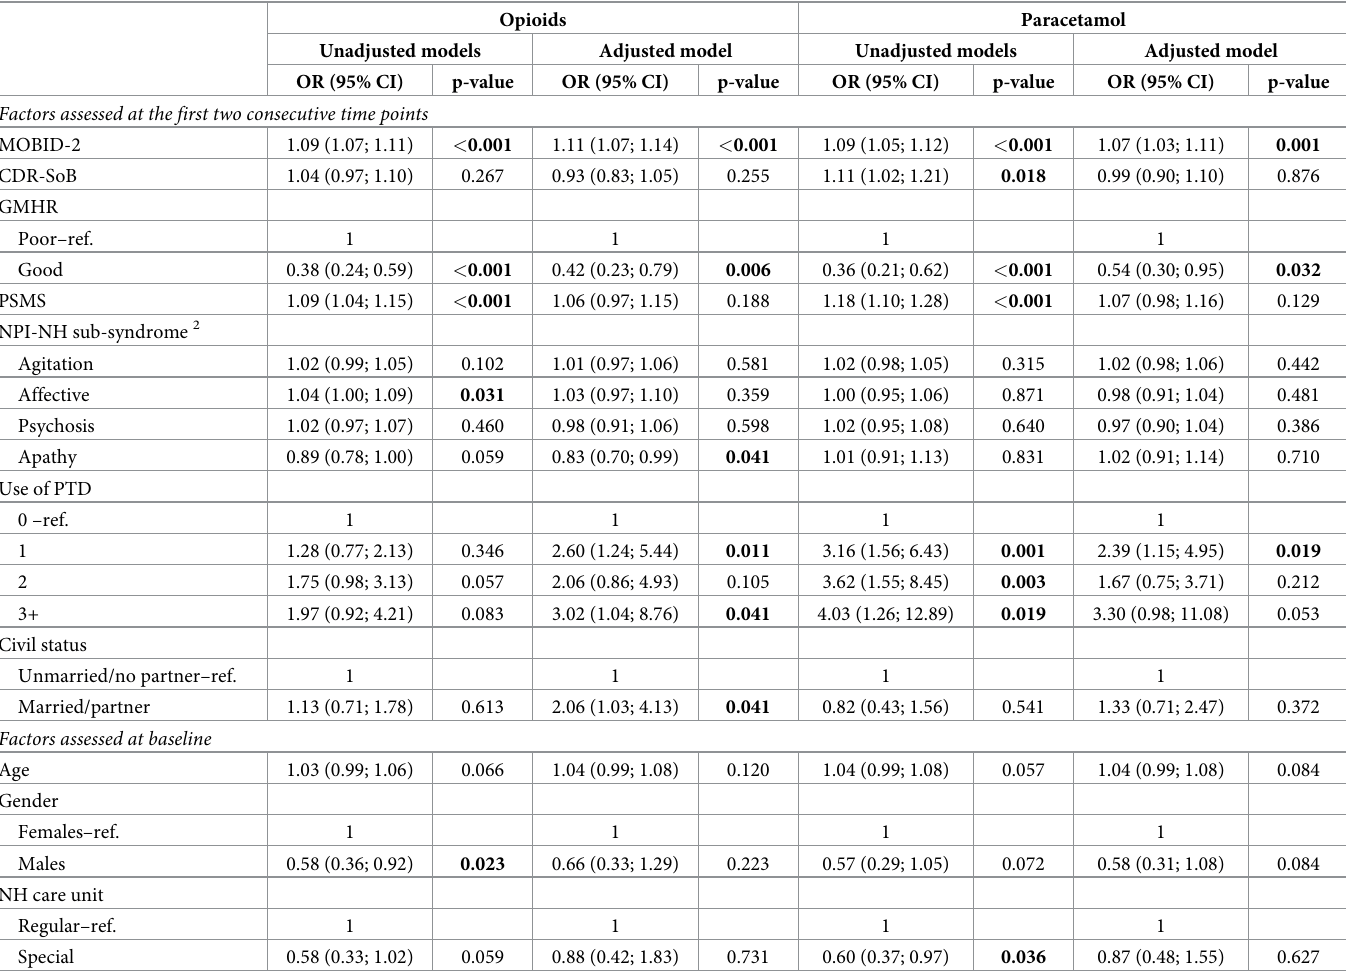
Table 4. Factors associated with persistent prescription of analgesics at two consecutive time points. Results of generalized linear mixed model 1 (N =